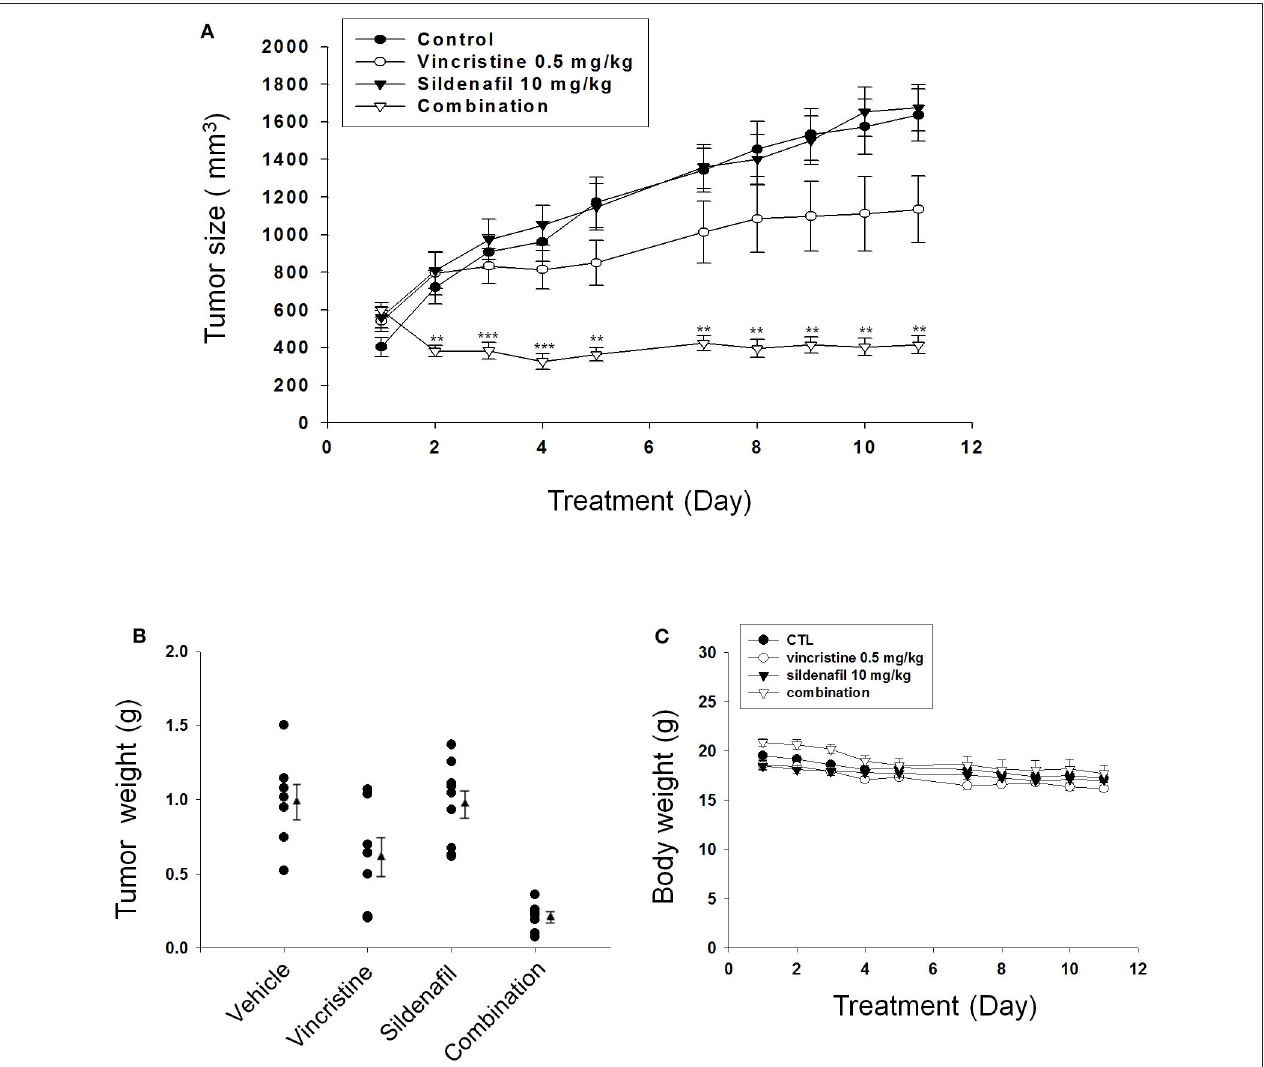
FIGURE 6 | Effect of sildenafil and vincristine on tumor growth in an in vivo anti-tumor xenograft model. The nude mice were subcutaneously injected with PC-3 cells (10 7 cells/mouse). The tumors were measured every day. When the tumors reached to a volume of 400–600 mm 3 , the mice were divided into four groups and the drug administration was initiated as described in the Materials and methods section. (A) The length ( l ) and width ( w ) of the tumor were measured, and tumor volume was calculated as lw 2 /2. The tumor weights (B) and the body weights (C) also were measured. Data are expressed as mean ± SEM. ** P < 0.01 and *** P < 0.001 compared with vincristine